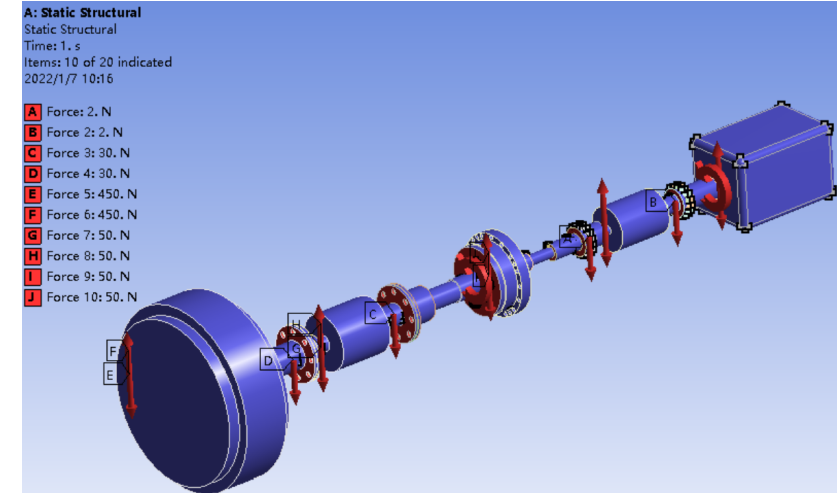
Figure 3. Boundary condition model of the transmission system. Table 5. Radial tilt angle of transmission system